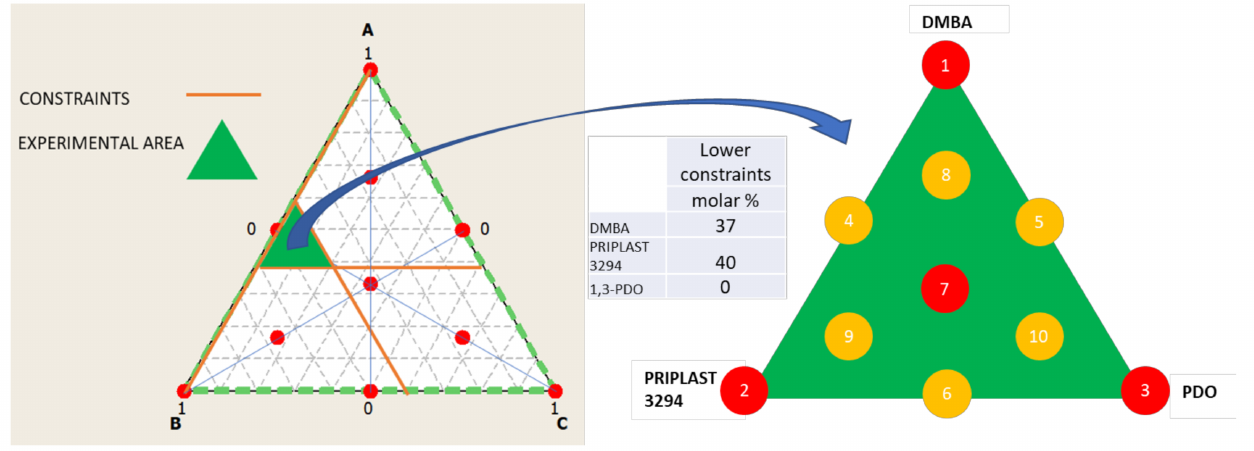
Figure 3. Ternary mixture design of experiments employed to study the proportion between the tree diols that form part of the polymer. ( Left ): in white full design surface area with all the theoretical experimental points marked in red and studied area in green which is delimited by the lower constraints stablished for component A (DMBA) and B (Priplast). Middle: table summarizing the lower constraints stablished for the diols. ( Right ): area studied and experimental points of de simplex design plot (from 1 to 7), experiments marked in red have been performed in this work (1, 2, 3, 7) while experiments that are marked in yellow have not been carried